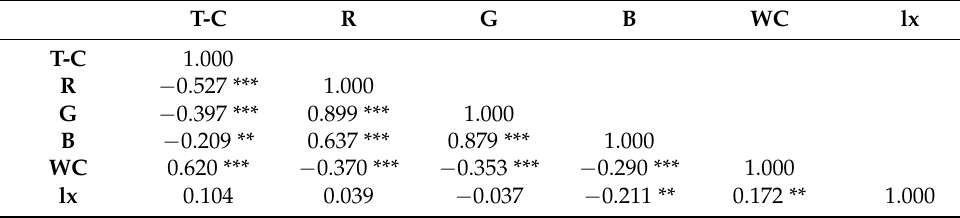
Table 3. Pearson correlation coefficient table of the US soil components. T-C R G B WC lx T-C 1.000 R − 0.527 *** 1.000 G − 0.397 *** 0.899 *** 1.000 − 0.209 ** 0.637 ***